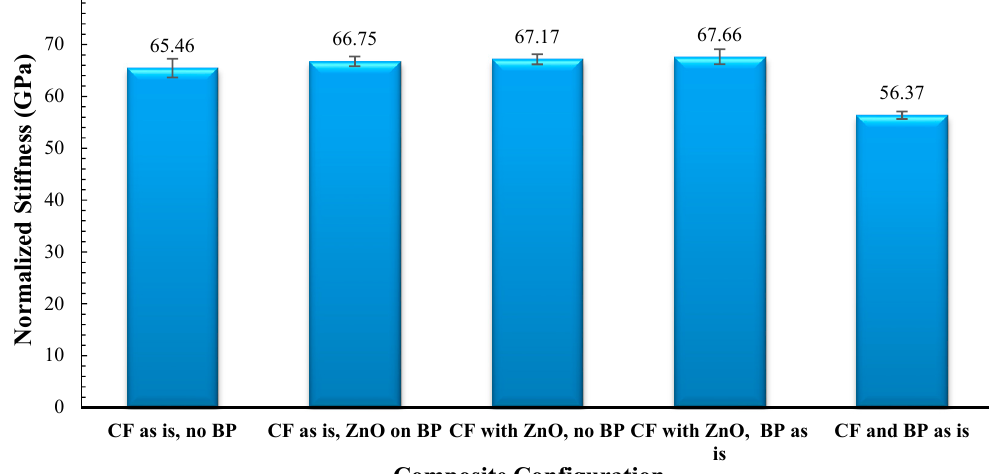
Figure 6. Comparison of normalized stiffness for different configurations.